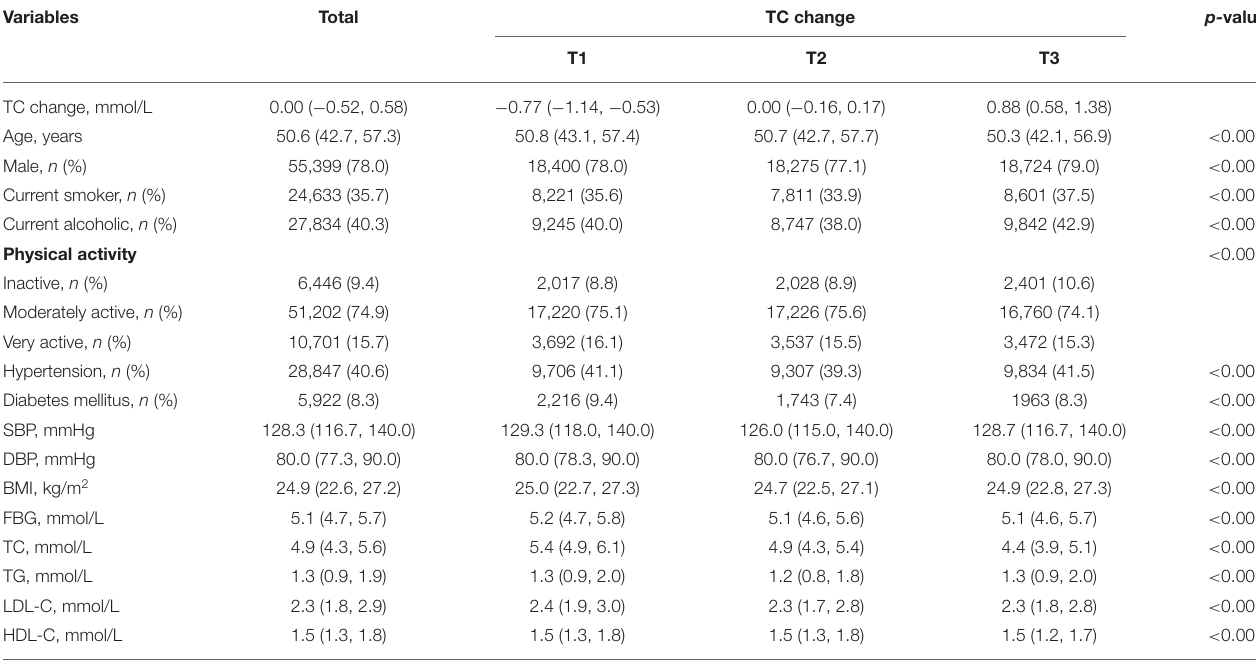
TABLE 1 | Baseline characteristics of participants according to the tertile of 2-year TC change. Variables